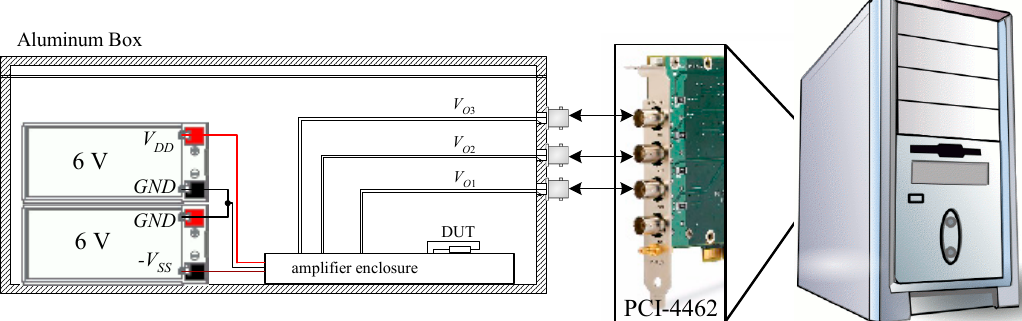
Figure 6. Block diagram of the measurement setup. Two lead acid 6 V batteries are used to supply the amplifier. The batteries, the amplifier and the DUT are all located inside an aluminum box that acts as a shield against external interferences.